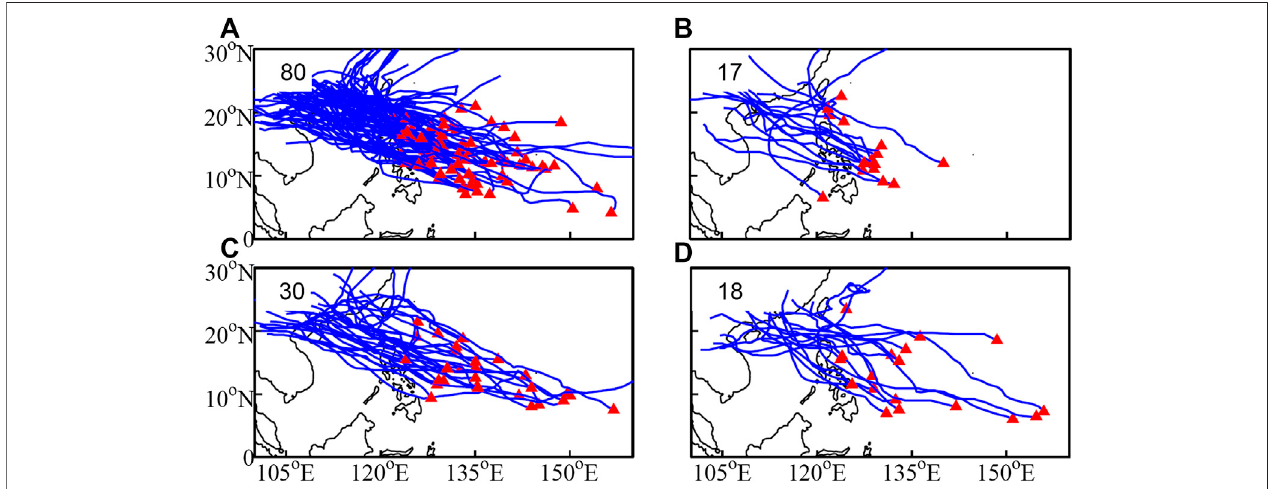
FIGURE5| TracksofnonlocalTCsinthecombinedphasesofQBWOandMJO.Redtrianglesrepresentthegenesislocationsofnon-localTCs. (A) isfortheactive phases ofboth MJO and QBWO, (B) isfor the active phases ofMJO alongwith the inactive phases ofQBWO, (C) is forthe inactive phases of MJO along with theactive phases of QBWO, and (D) is for the inactive phases of both MJO and QBWO.